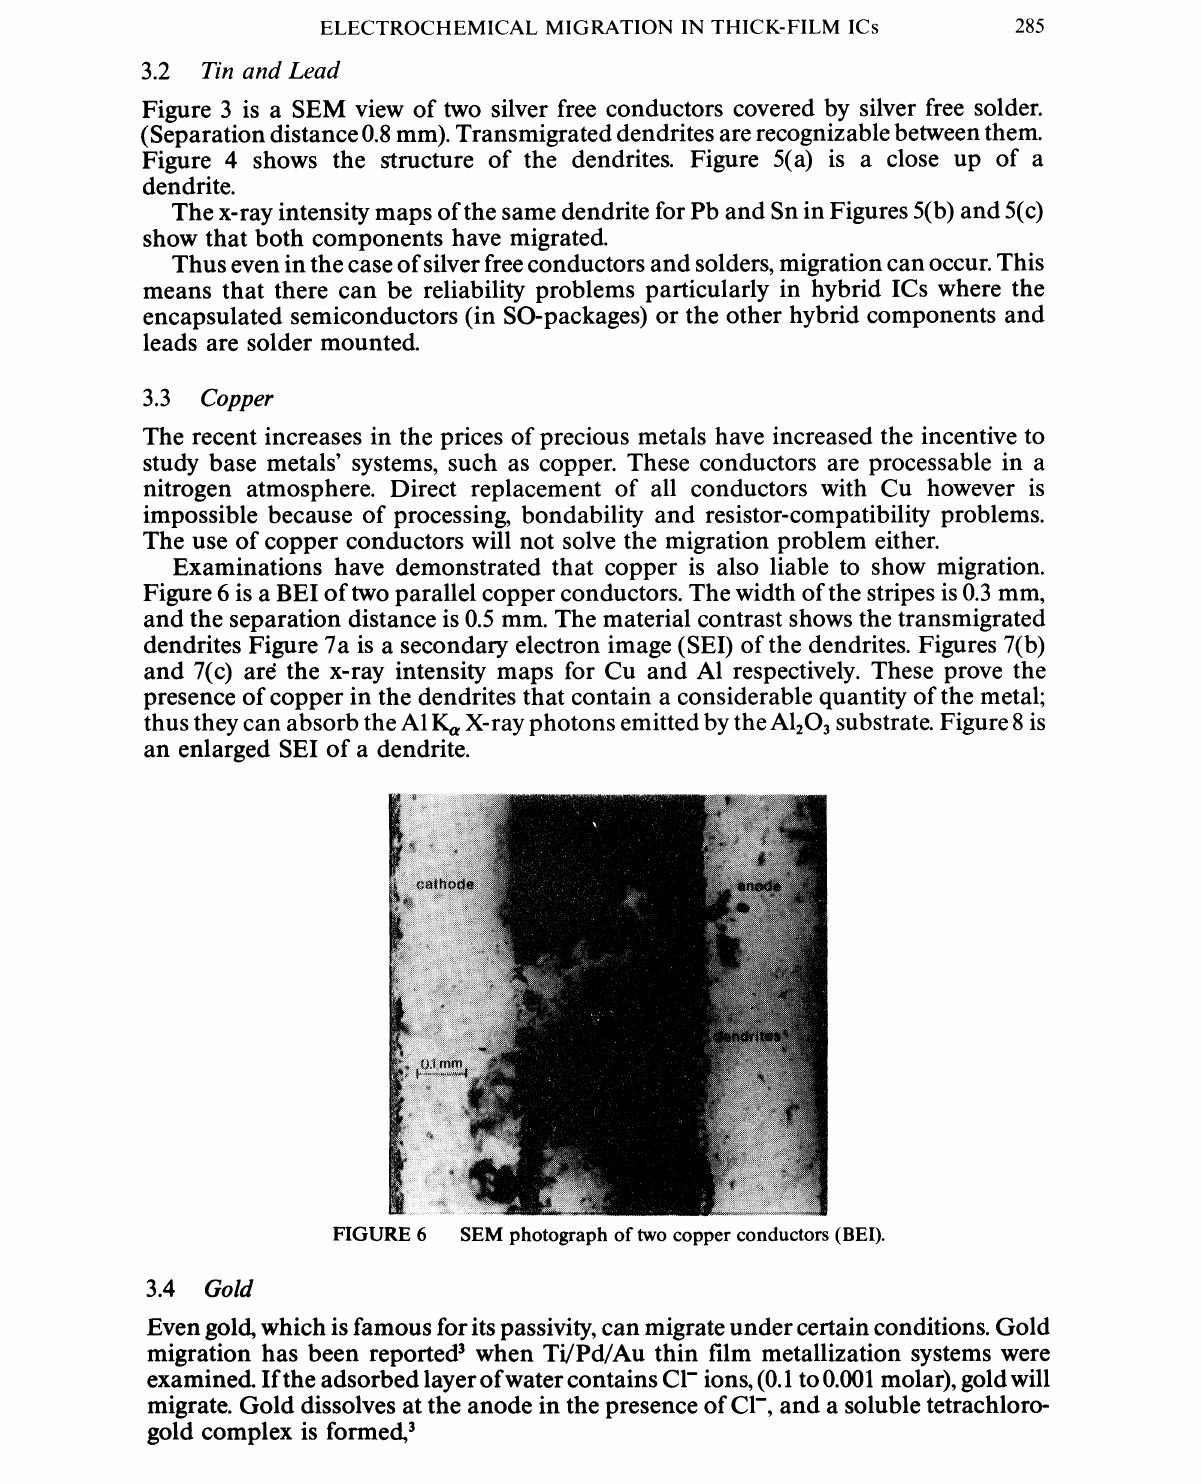
SEM photograph of two copper conductors